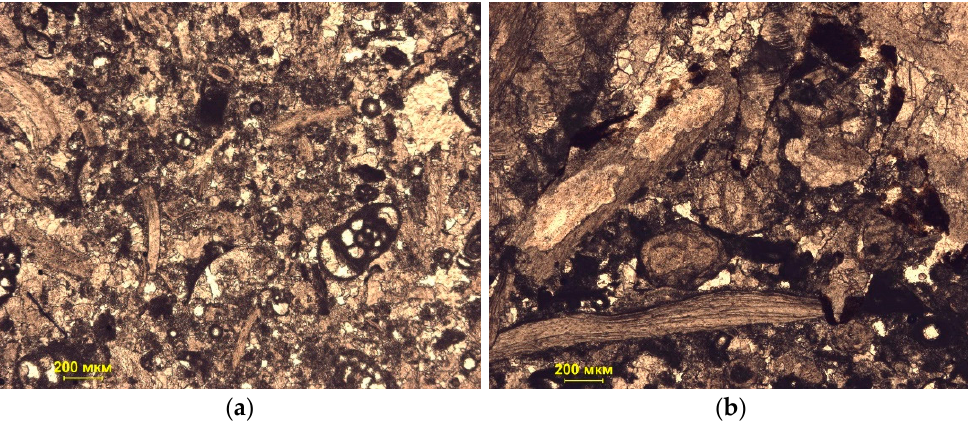
Figure 5. Micrographs of a thin section made from a rock sample: ( a ) fragments of shells of brachiopods, foraminifera, ostracods cemented with secondary calcite sparite cement; ( b ) a fragment of a brachiopod shell, the chamber of which is made of quartz grains, a fragment of a stylolite suture.